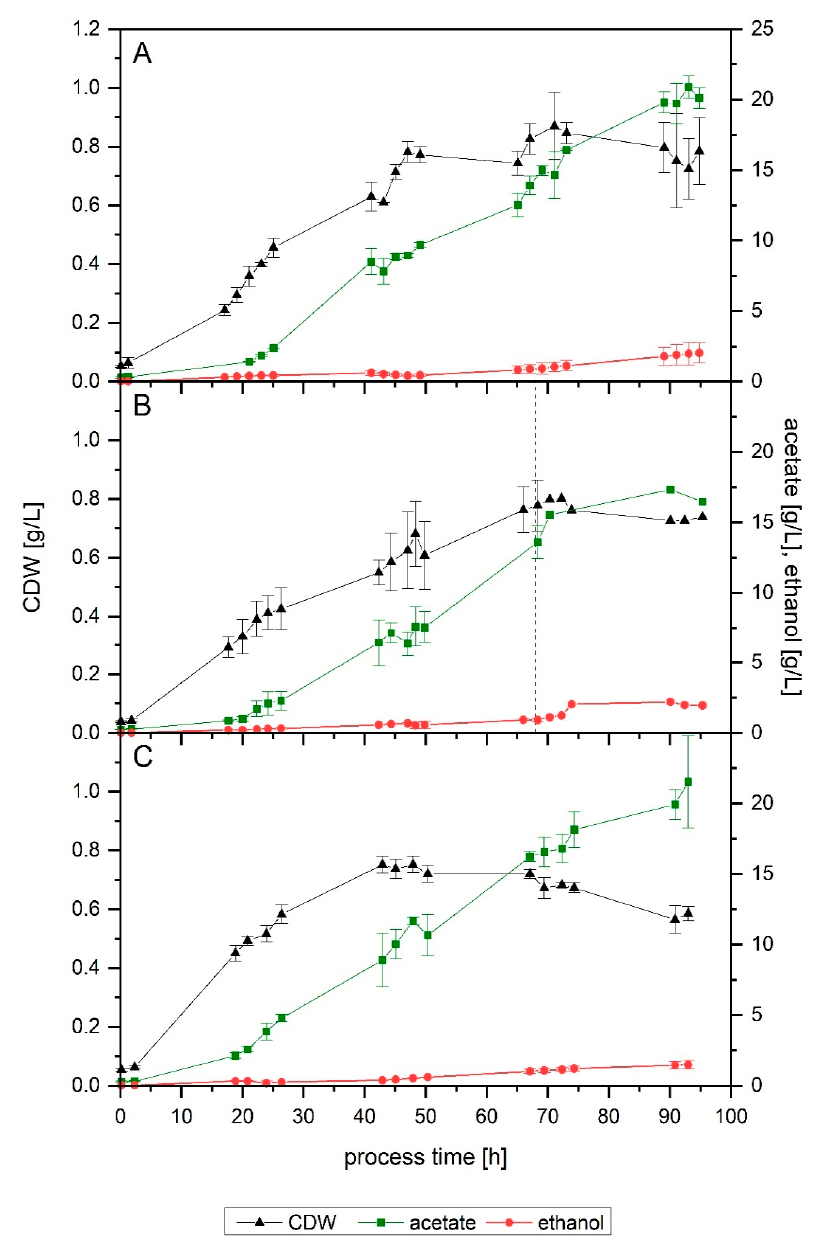
Figure 1. Growth and product formation of: Setup 1 ( A ); Setup 3 with increased cysteine ( B ); and Setup 4 with increased yeast extract ( C ). In ( B ), the average of three fermenters is shown up to 68 h (vertical line). Afterwards, only the fermenter kept at pH 5.9 is shown (Setup 3a). Average values of the triplicates ( n = 3) with STD for cell dry weight (CDW, black triangles), acetate (green squares) and ethanol (red dots). Points indicate actual measurements. Lines are only depicted for clarity purposes.